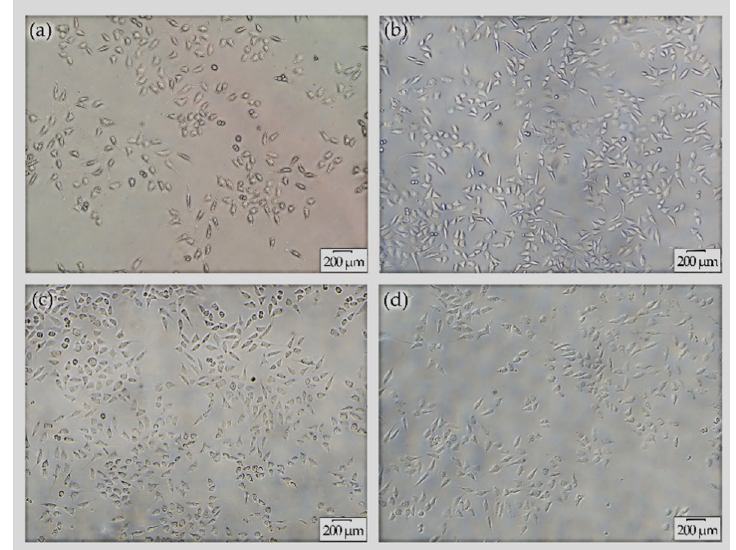
Figure 9. Cell morphology under inverted microscope (20×) for L-929 cells cultured with extracts from ( a ) AZ31, ( b ) MAO/AZ31, ( c ) Cu/MAO/AZ31, and ( d ) the negative group for 4 days.